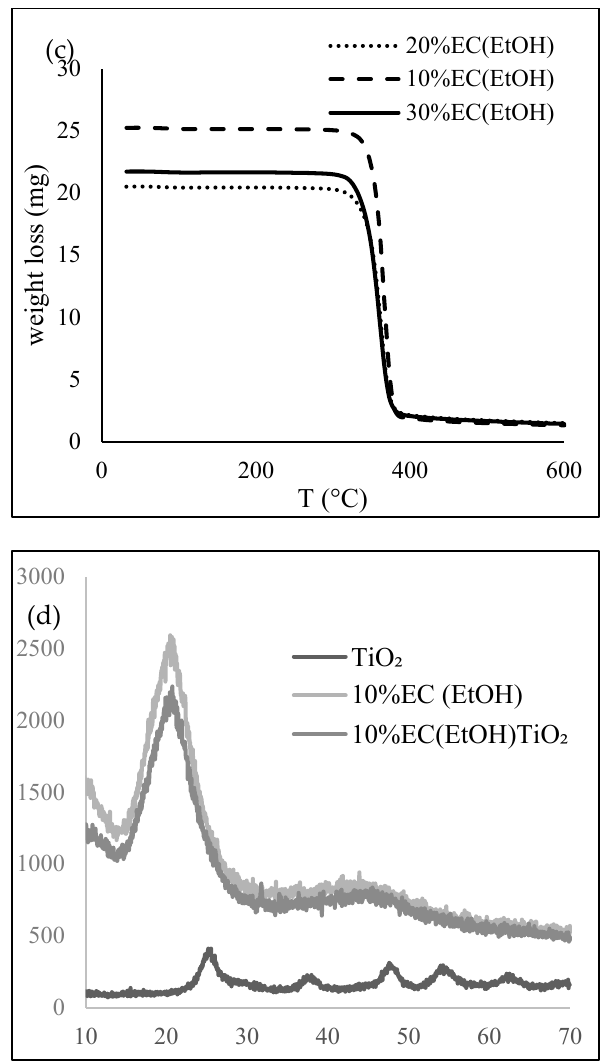
Figure 2. ( a ) FTIR, ( b ) DSC, ( c ) TG, and ( d ) XRD of prepared EC samples.